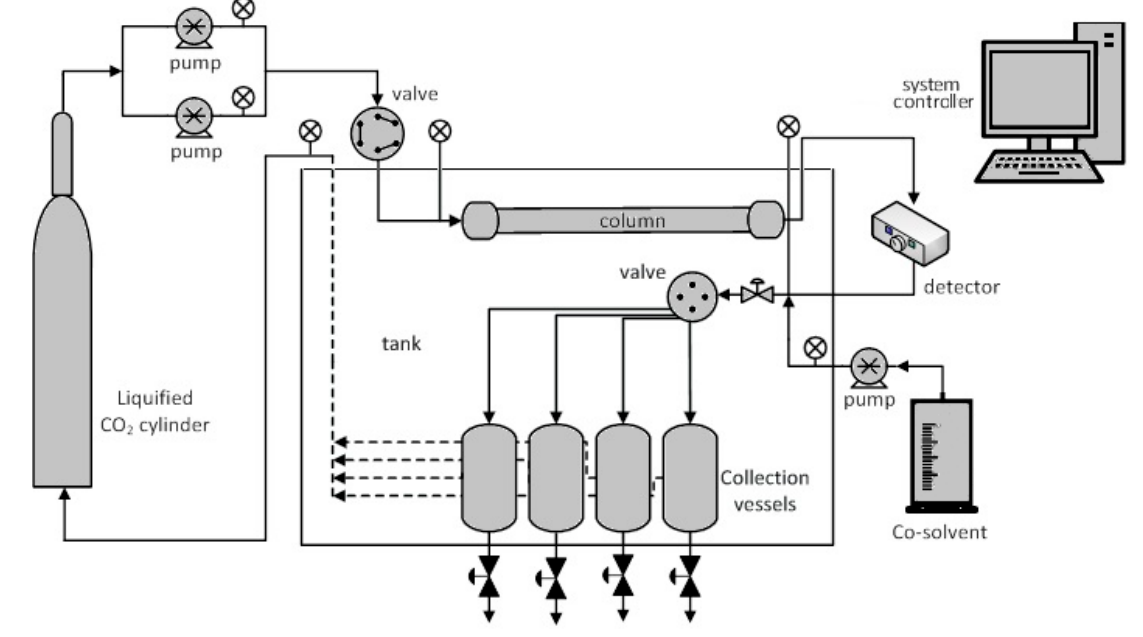
Figure 1. Schematic diagram of a SFC experimental apparatus.